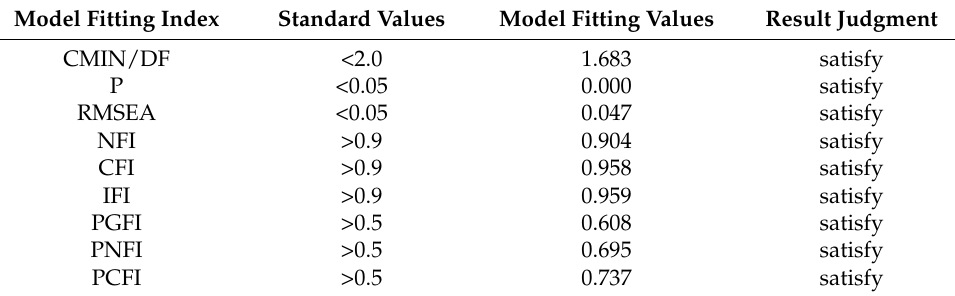
Figure 5. Structural equation model analysis chart. Table 6. Fitting results of structural equation model.